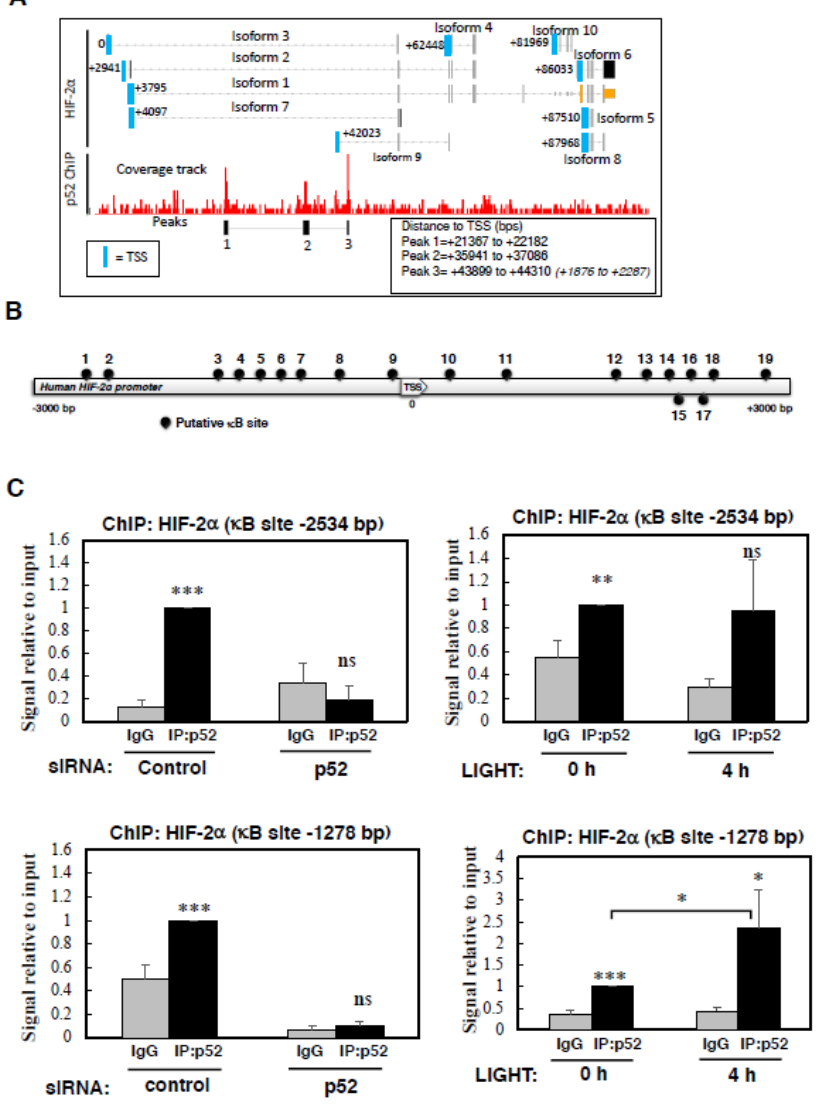
Figure 4. The NF- κ B subunit, p52, specifically binds to multiple sites on the HIF-2 α promoter. ( A ) Coverage tracks and peaks from L1236 p52 ChIP-seq data at the HIF-2 α gene. Peak start and end distances from the HIF-2 α transcription start site (TSS) are also shown. (Numbers in brackets) = distances from HIF-2 α isoform 9 (EPAS-209 (ensembl transcript name)) TSS. ( B ) Schematic diagram showing annotations of putative κ B binding sites identified on the promoter region ( − /+ 3000 bp from TSS) of HIF-2 α gene through bioinformatics analysis conducted using ALGGEN PROMO software. 4 out of 19 sites were subjected to further analysis, to be confirmed as binding sites for the NF- κ B subunit p52. ( C ) HeLa cells were transfected with siRNA control and p52 oligonucleotides for 72 h prior to cross-linking and lysis ( left panels ) or treated with 100 ng/mL LIGHT for the 0 and 4 h prior to cross-linking and lysis ( right panels ). Chromatin immunoprecipitations (ChIPs) were performed for the levels of p52 present at the indicated putative κ B sites on the HIF-2 α promoter. Rabbit IgG was used as antibody control. All of the graphs depict mean and SEM of a minimum of three independent biological experiments. Student t test was performed and significance determined as follows: ns = not significant, * p ≤ 0.05, ** p ≤ 0.01, *** p ≤ 0.001. One way Anova analysis was also performed to compare multiple conditions and significance determined as follows: * p ≤